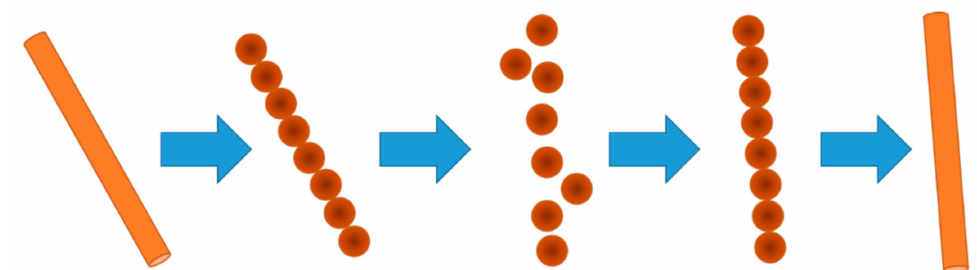
Figure 1. Basic concept of driftwood model with connected spherical